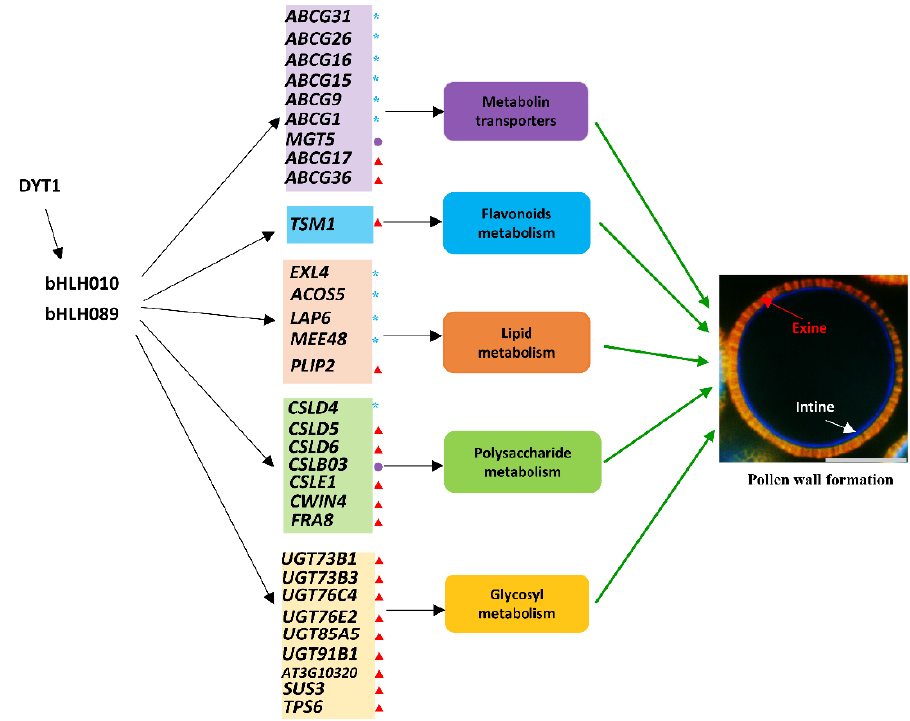
Figure 8. A proposed model of how bHLH transcription factors regulate pollen wall development. Based on transcriptome and metabolome data of bhlh010 bhlh089 , the transcript level of enzymes and transporters was significantly downregulated. Metabolism-related enzymes and transporters affect pollen wall morphogenesis by regulating the metabolic accumulation of polysaccharides, lipids, flavonols, and other substances. In this study, we identified these new candidate genes that may regulate pollen wall morphogenesis. The blue asterisks indicate genes associated with the development of the exine, the purple circles indicate genes associated with the development of the intine, and the red triangles indicate genes that may be involved in the development of a pollen wall.